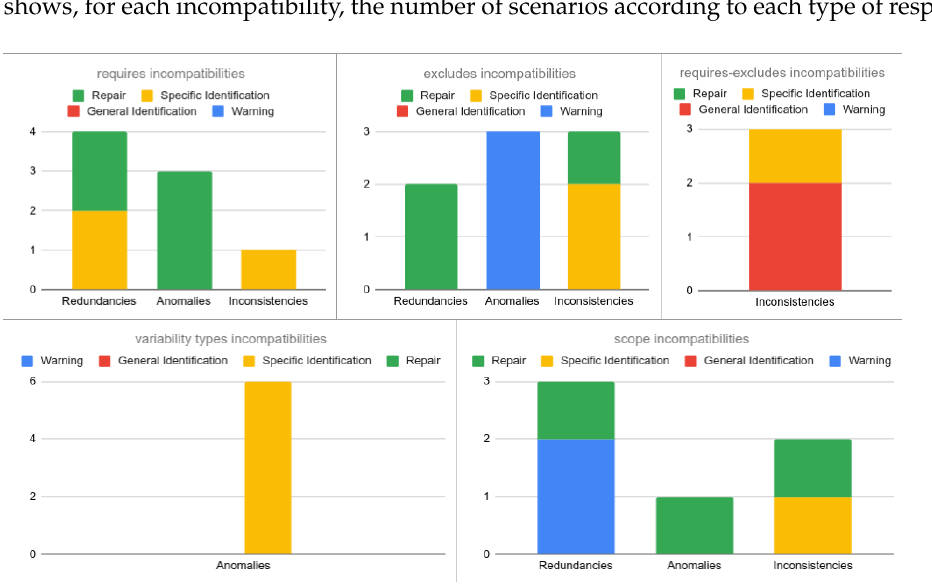
Figure 14. Summary of number of validation scenarios according to the response of the validator. Configurator (Component